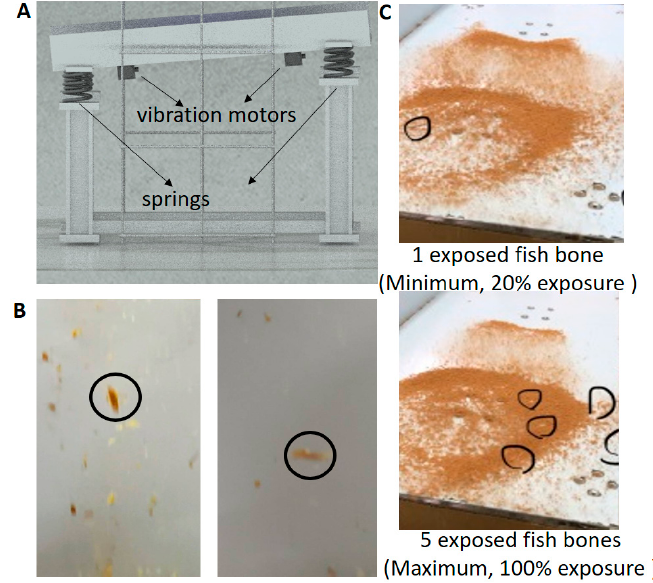
Figure 8. Two separation mechanisms of the vibration unit: ( A ) the unit scheme, and the mechanisms of ( B ) air separation, and ( C ) downstream separation. The tested mixture was composed of five fish bones and 500 g of fish floss.